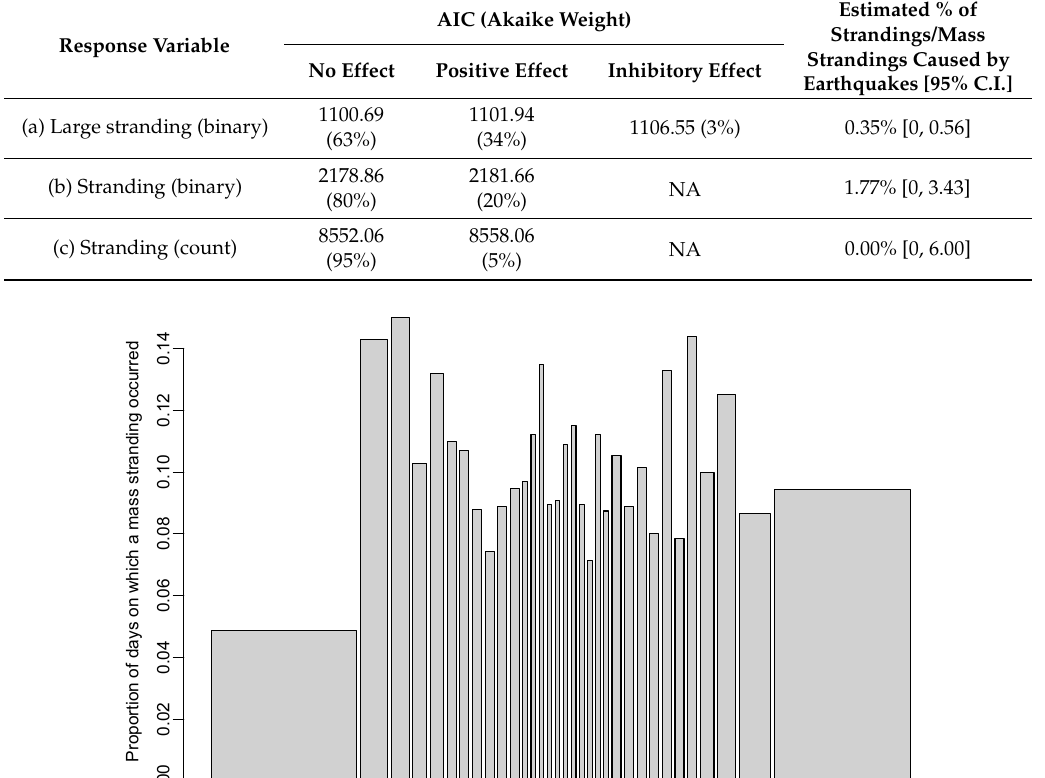
Table 2. Statistical outcomes for single and large stranding events.